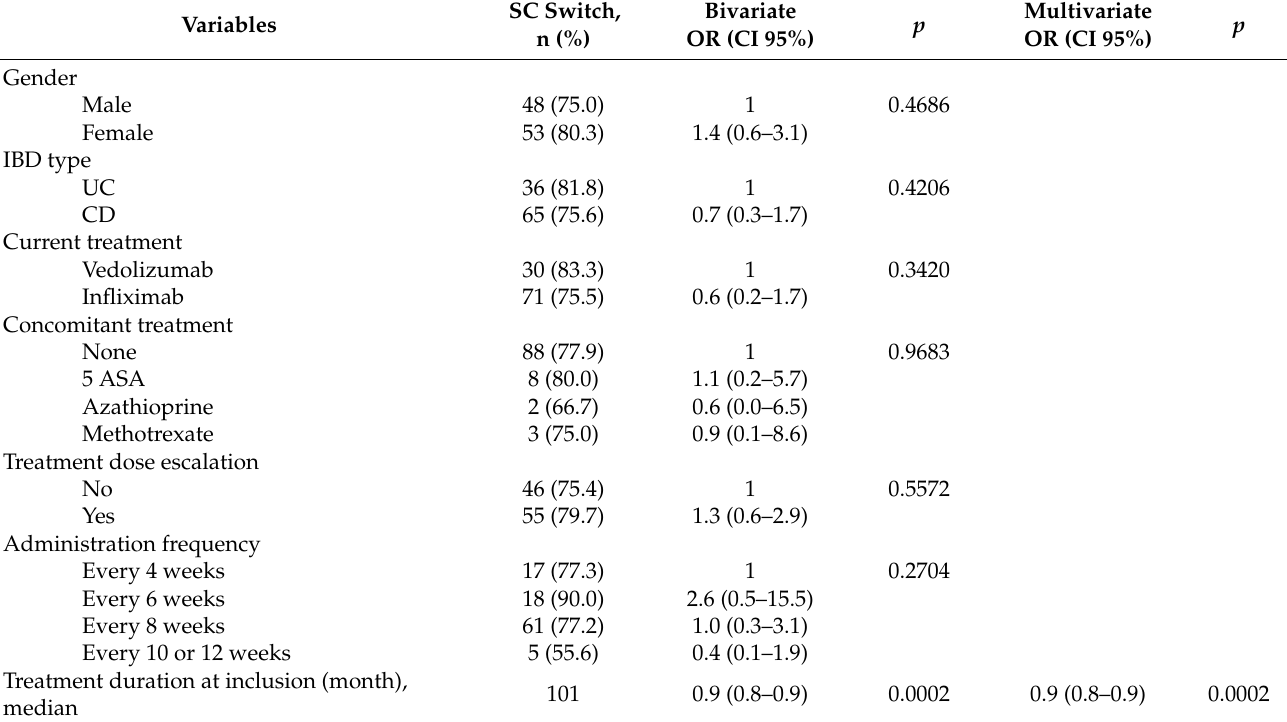
Table 6. Factors associated with patient’s acceptance for switching from IV to SC